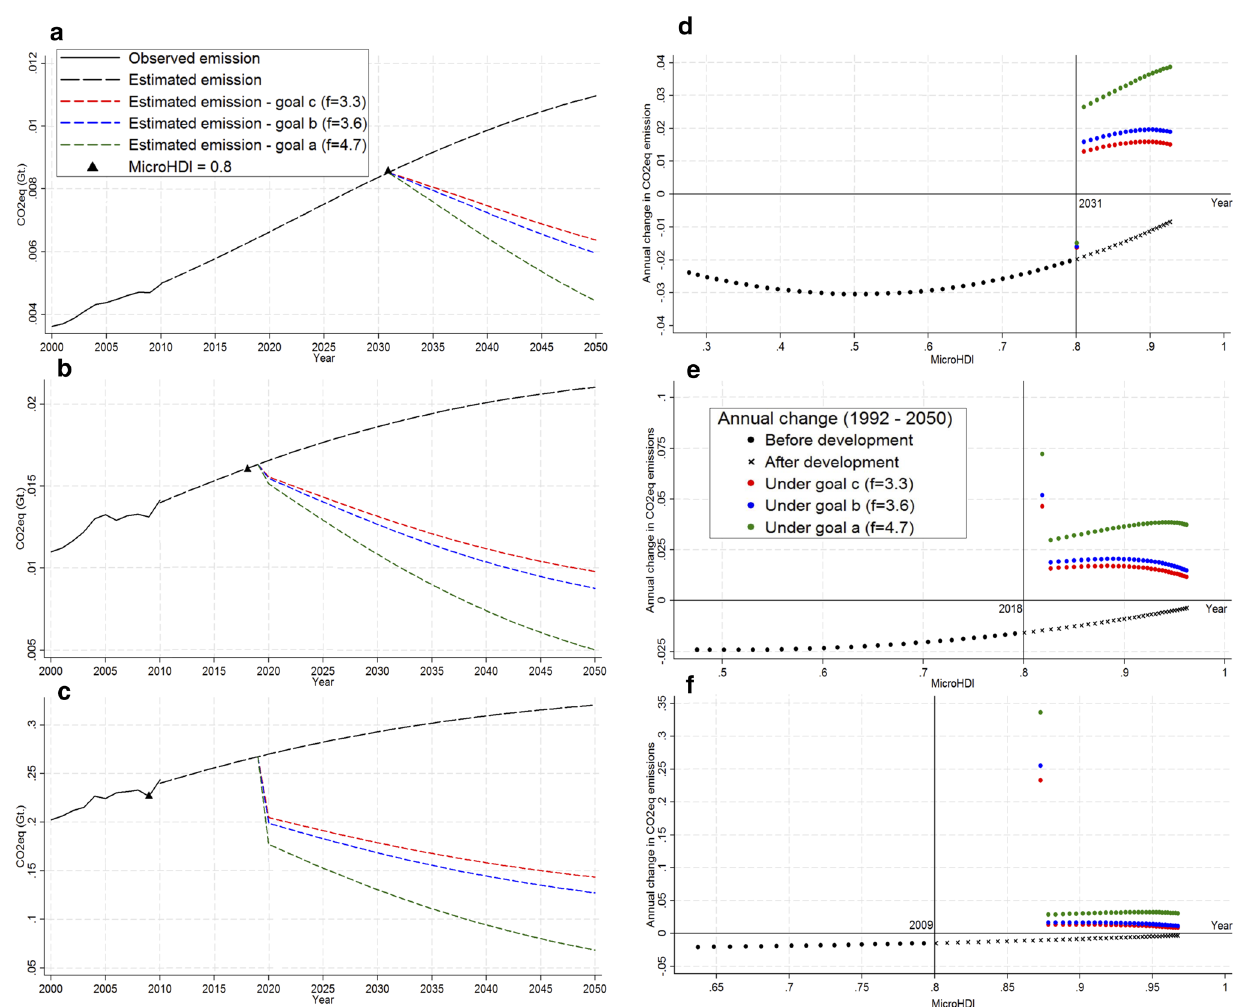
Fig. 6 Annual CO eq emissions (2000–2050) and CO eq emissions reduction framework based on MicroHDI (1992–2050) for some contrast- 2 2 ing Brazilian microregions . Annual CO eq emissions observed and estimated and the mitigation goal implications for Vale do Ipanema—PE 2 ( a ), Teresina—PI ( b ) and São Paulo—SP ( c ). Annual change in CO eq emissions over the years under DAU approach and under the emis- 2 sions reduction framework for Vale do Ipanema—PE ( d ), Teresina—PI ( e ) and São Paulo—SP ( f ). The y-axis of the Cartesian plane has been reversed in order to follow the same theoretical reasoning presented by Costa and co-workers [12]. The vertical solid line indicates the human development threshold of 0.8 MicroHDI, representative of a very high development standard. The CO eq mitigation goals indicate 2 reductions in 2050 related to 2010. In the goal a : 56.5%; goal b : 26.5% and goal c :